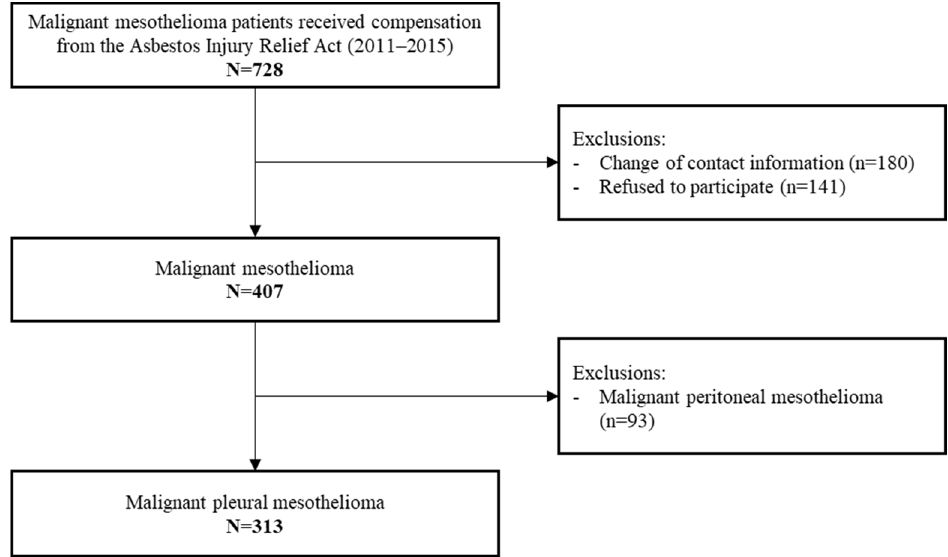
Figure 1. Flowchart showing the selection of study patients.